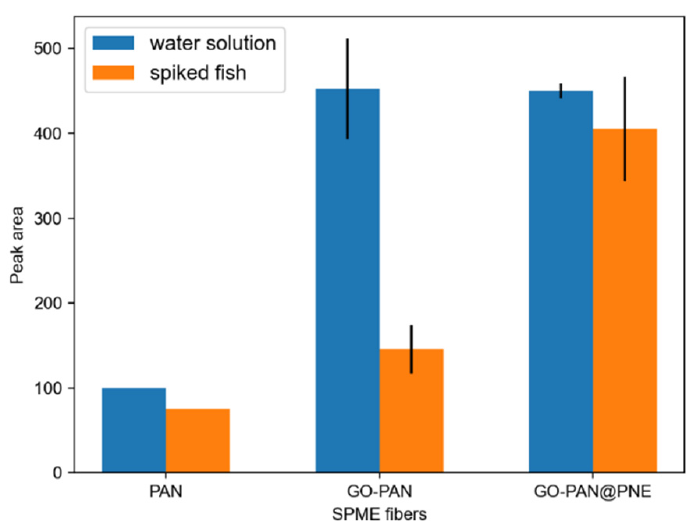
Figure 3. In vitro evaluation of extraction performance of PAN, GO-PAN, and GO-PAN@PNE fi- bers.